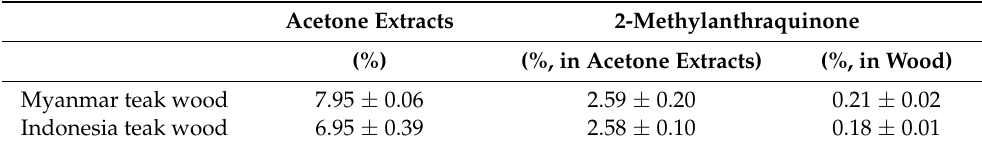
Table 2. Contents of natural 2-methylanthraquinone in Myanmar and Indonesia teak woods.